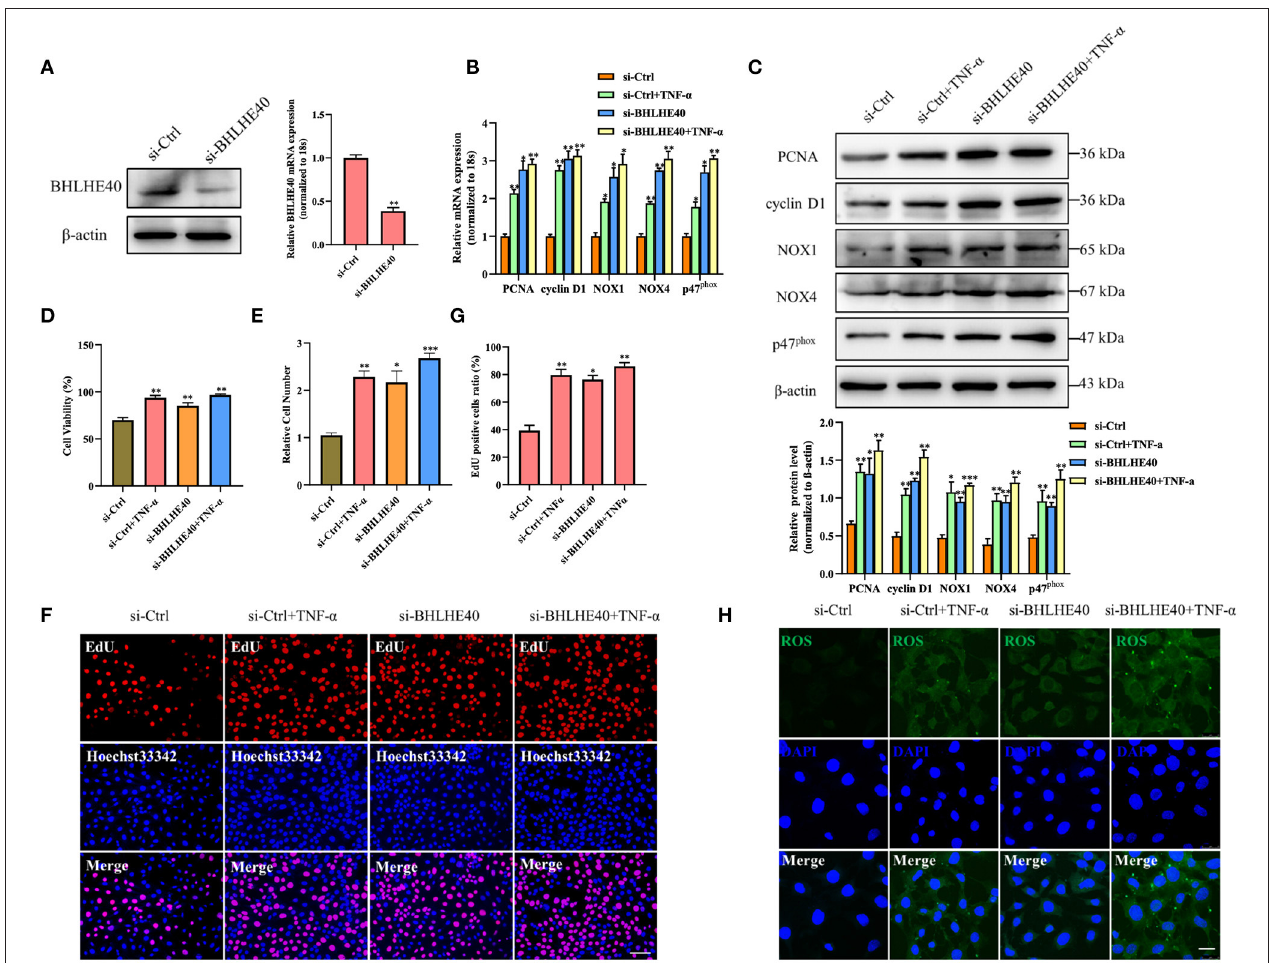
FIGURE 4 | Downregulation of BHLHE40 promotes TNF- α -induced proliferation and oxidative stress in VSMC. (A) VSMCs were transfected with si-BHLHE40, and the expression of BHLHE40 was detected by Western blotting and qRT-PCR. ** p < 0.01 vs. si-Ctrl group. (B–H) VSMCs were transfected with si-BHLHE40 and then treated or not with TNF- α for 24h. The expression of PCNA, cyclin D1, NOX1, NOX4 and p47 phox was determined by qRT-PCR (B) and Western blotting (C) . Statistic of band intensities is shown on the bottom. * p < 0.05, ** p < 0.01 and *** p < 0.001 vs. si-Ctrl group. The cell viability was determined by MTS assay (D) , and cell counting was carried out using a Countess automated counter (E) . * p < 0.05, ** p < 0.01 and *** p < 0.001 vs. si-Ctrl group. Cell proliferation was detected by EdU staining (F) . Scale bar = 100 µ m. Analysis of the percentage of EdU positive cells (G) . * p < 0.05, and ** p < 0.01 vs. si-Ctrl group. ROS levels were detected by DCFH-DA staining (H) . Scale bar = 25 µ